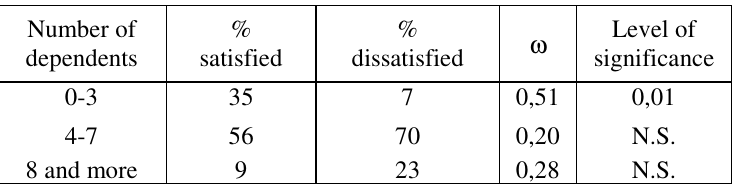
Black workers’ satisfaction with their pay (X.C. Birkenbach and R. van der